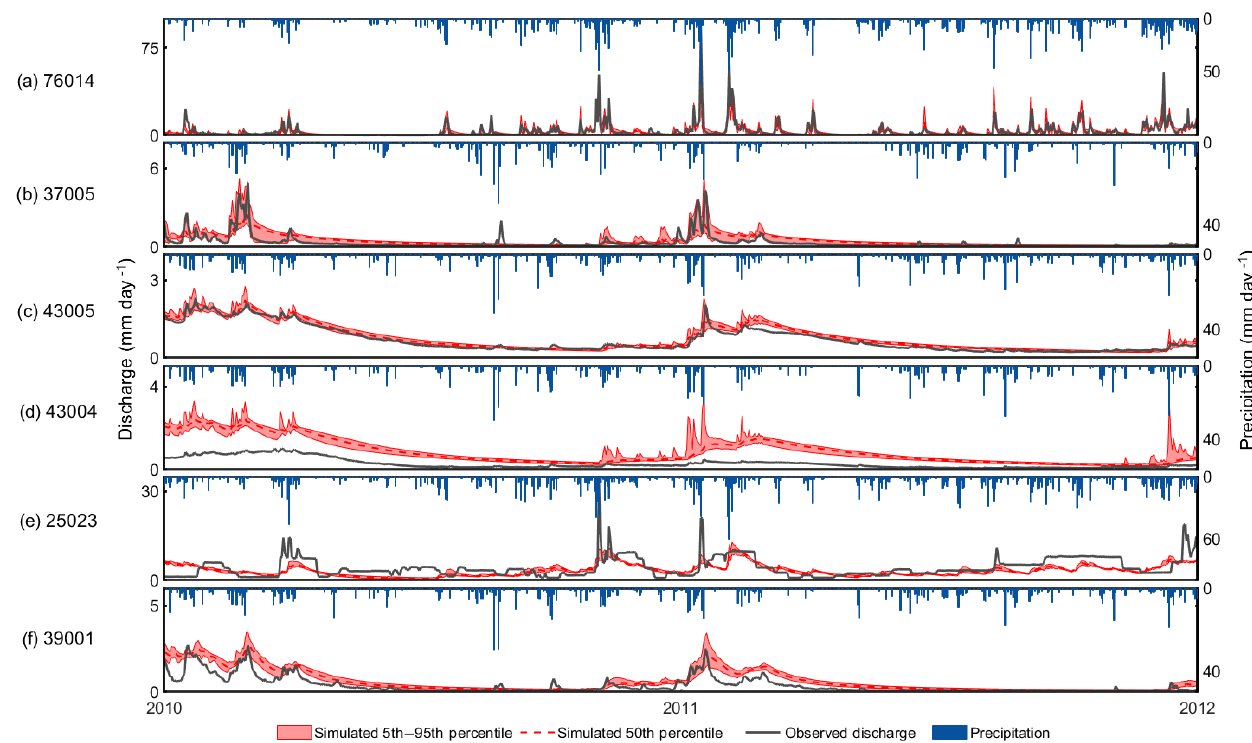
Figure 9. Observed discharge and uncertainty bounds for the behavioural simulations (5th and 95th percentile of the likelihood-weighted simulated discharge) for six catchments with different characteristics (shown in Table 5). The plots show a 2-year period (2010–2012) from the 55-year time series